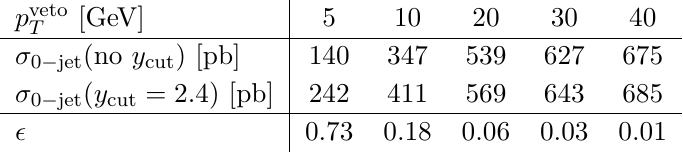
Table 5 . The Z + 0 -jet cross-section prediction at NNLO ( µ = Q ), with and without a jet rapidity cut.